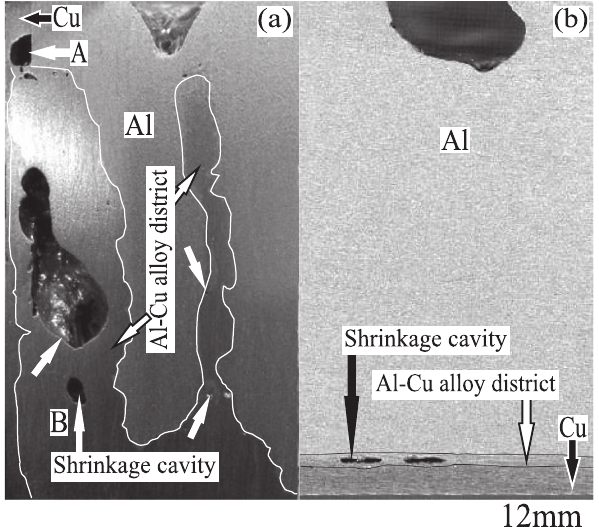
Figure 5: Shrinkage cavities photos in the transition layer under jet air cooling: (a) pouring at 830°C and holding for 110 s; and (b) pouring at 780°C and holding for 60 s.